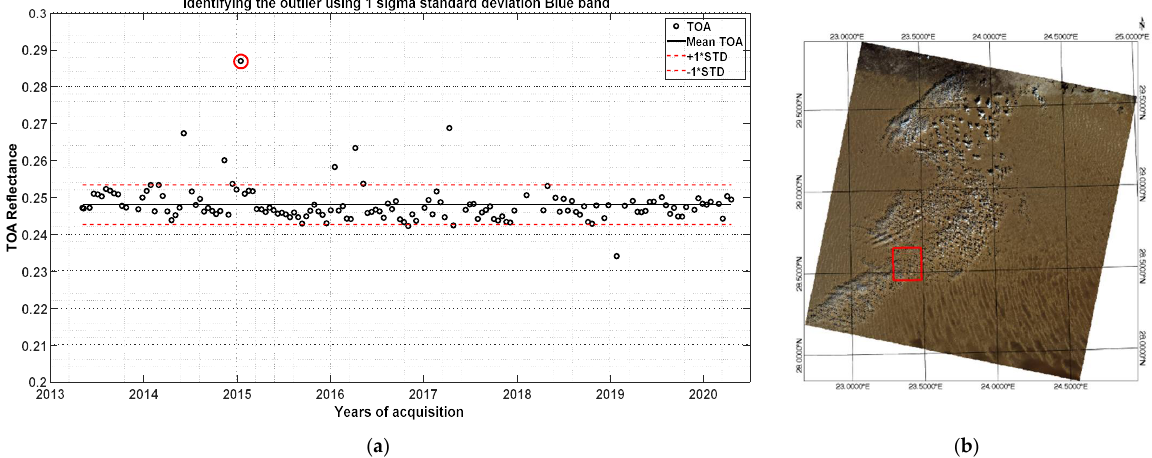
Figure 2. ( a ) Graph to illustrate the identification of outlier using 2-sigma standard deviation method; and ( b ) visual inspection of the image considered as a potential outlier.